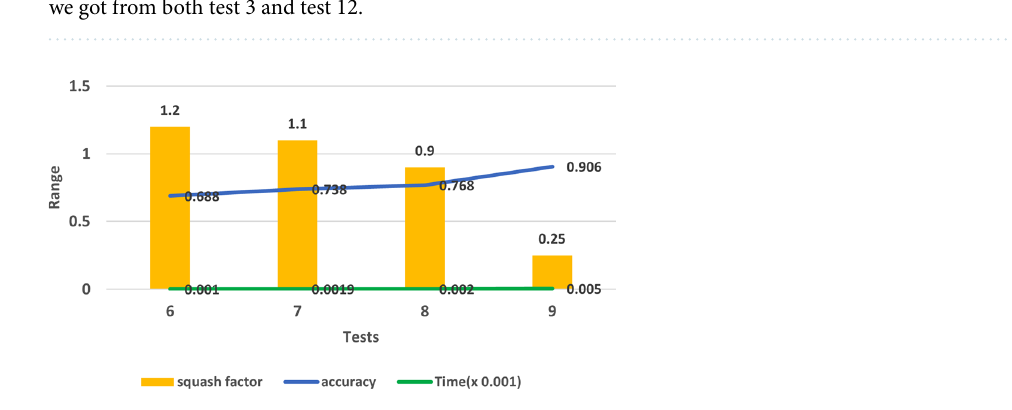
Table 1. The performance metrics of ANFIS classifier. Bold values indicates the highest evaluation matrices we got from both test 3 and test 12.